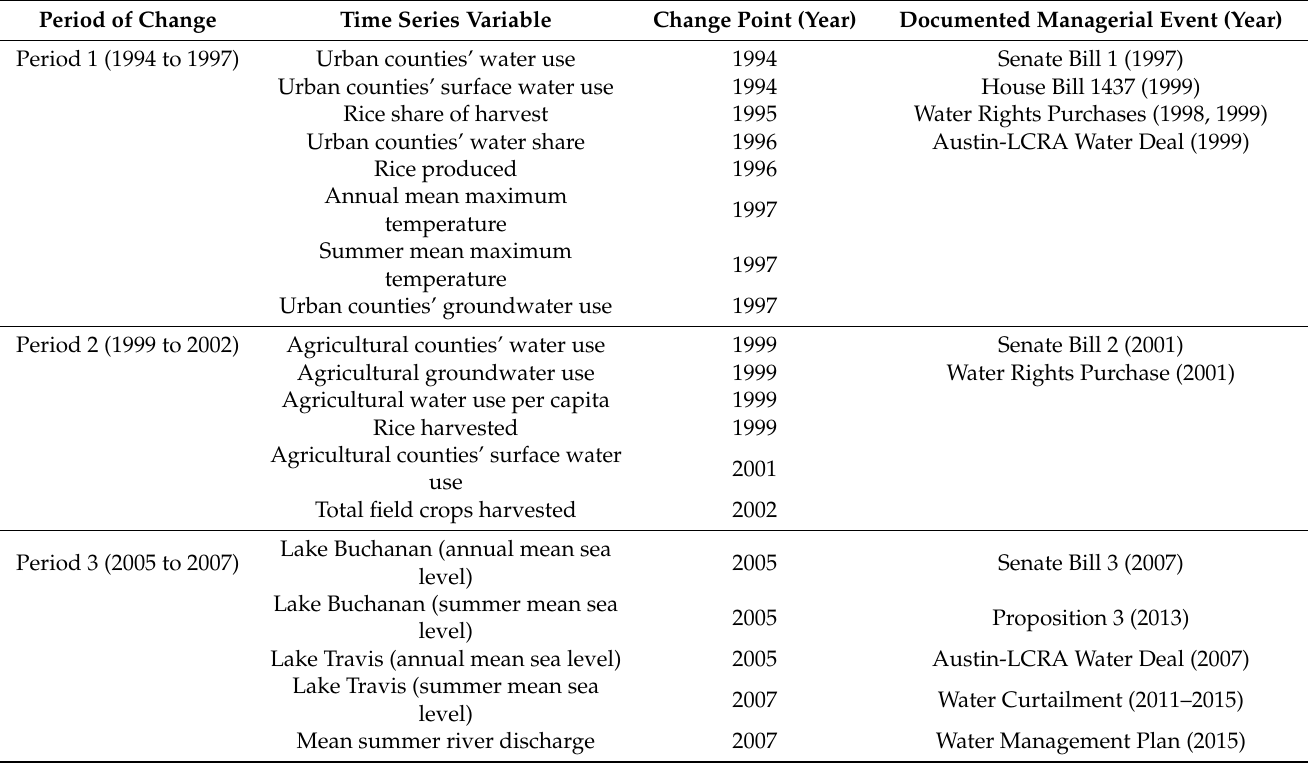
Table 2. Groupings of change points used to compare coincidental documented managerial interven- tions in water resource